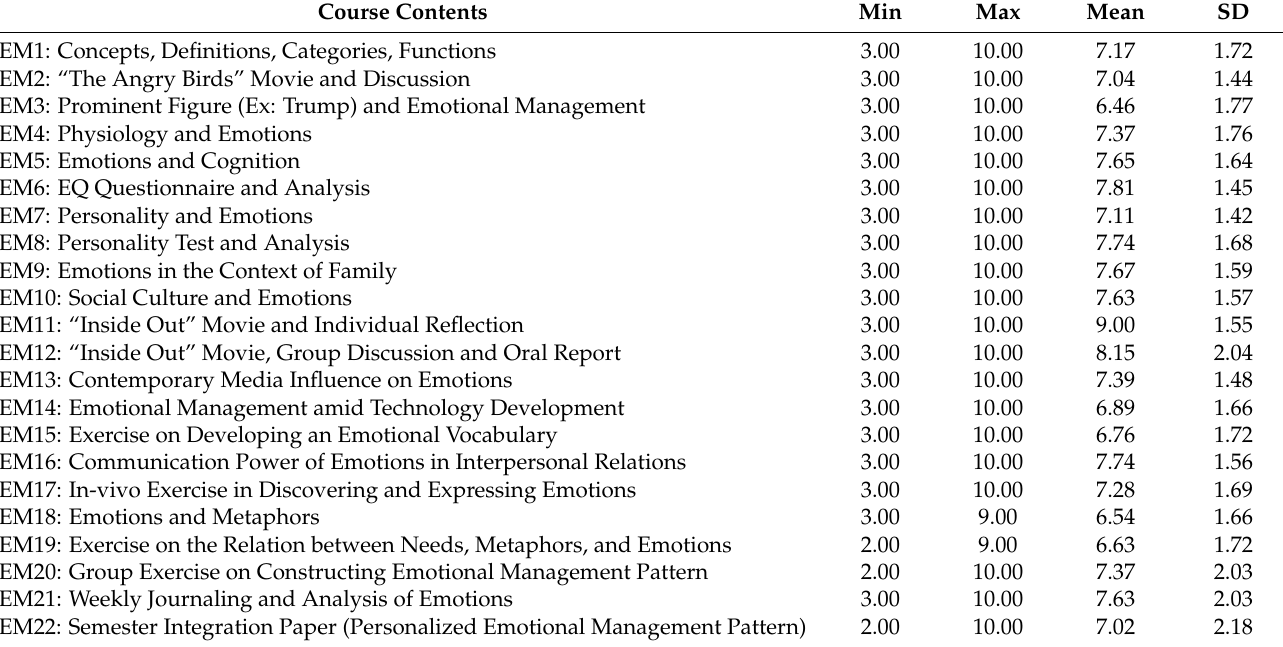
Table 3. Emotional management course contents and descriptive statistics (Study